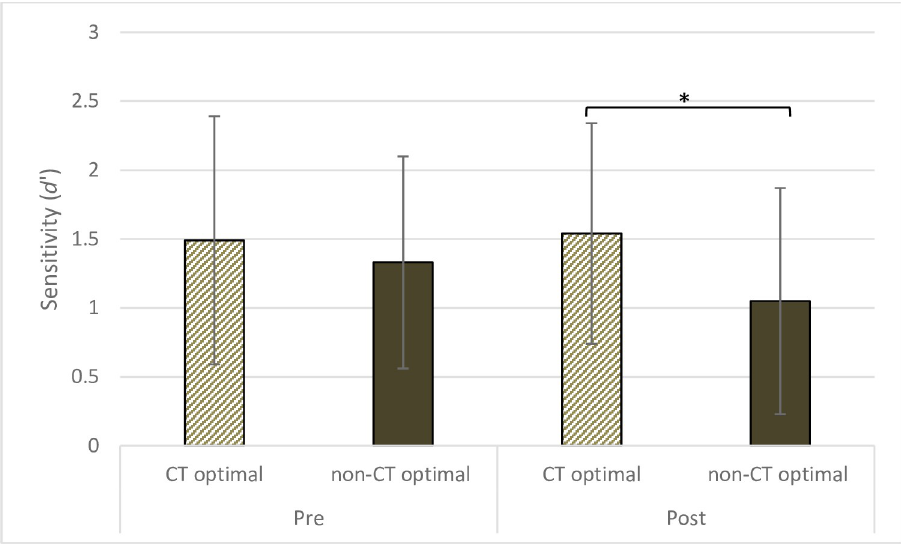
Fig 5. Mean d’ during the SSDT before (Pre) and after (Post) receiving the touch manipulation in the CT optimal and non-CT optimal group. Error bars show standard deviations. the CT optimal group showed a significantly higher d’ compared to the non-CT optimal group only during the second repetition (Post) of the SSDT.